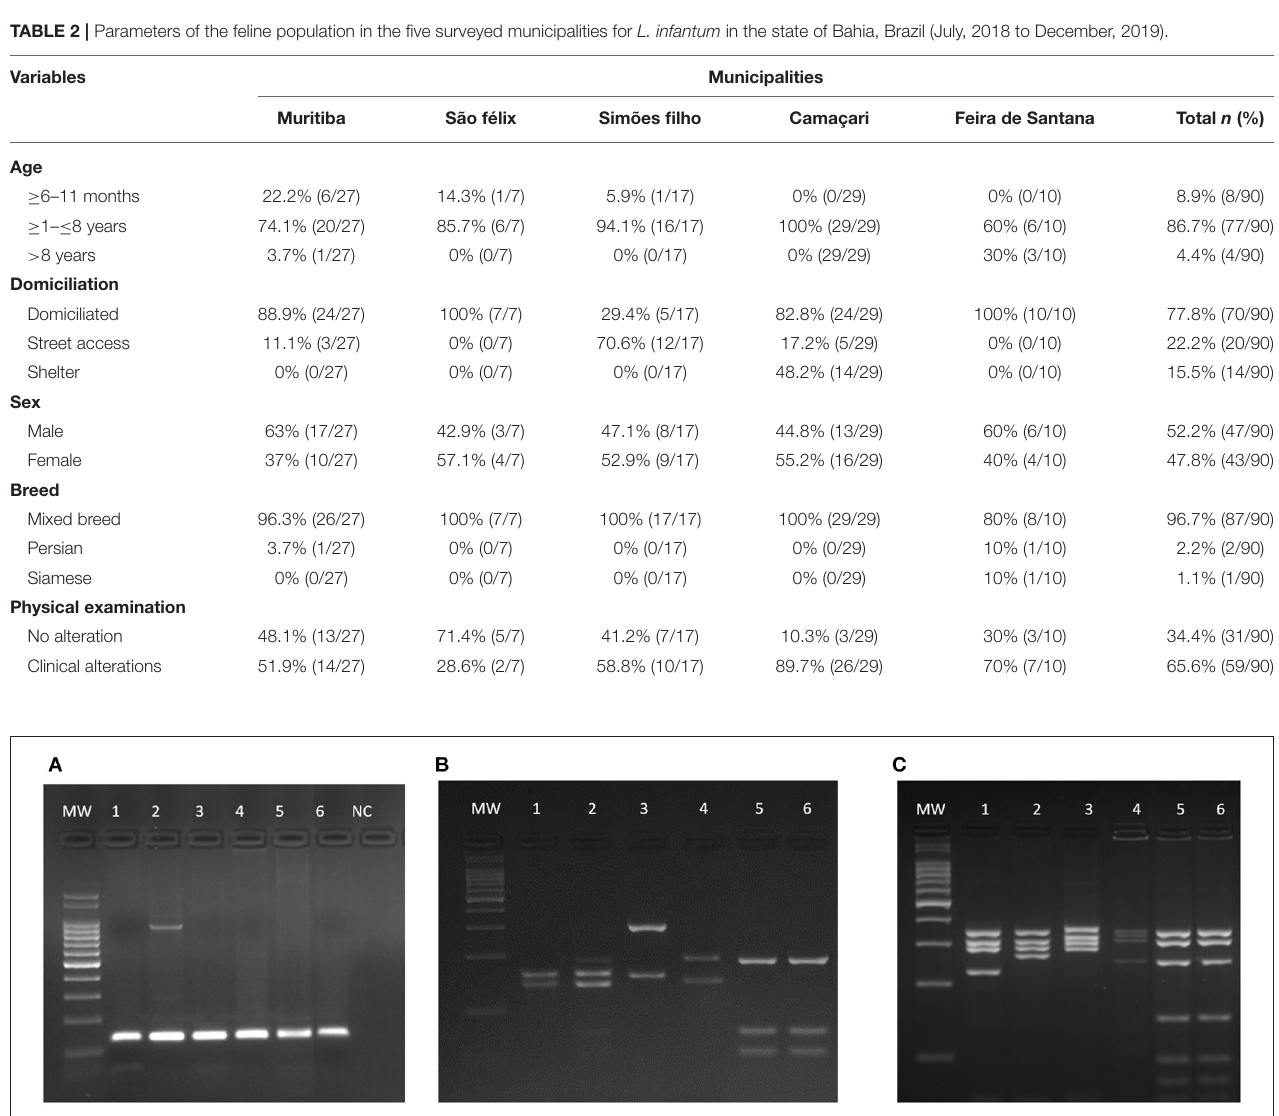
FIGURE 2 | Molecular identification of L. infantum isolated from a cat (CAT1). Agarose gels showing the expected 145-bp fragment for RV1-RV2 PCR (A) and PCR-RFLP restriction profiles of ITS1 (B) and HSP70 (C) fragments. MW − 100-bp molecular weight; 1– L. braziliensis (MHOM/BR/75/M2903); 2– L. guyanensis (MHOM/BR/75/M4147); 3– L. major (MHOM/IL/81/Friedlin); 4– L. amazonensis (IFLA/BR/67/PH8); 5– L. infantum (MHOM/BR/74/PP75); 6–CAT1 (isolated from cat); NC–negative